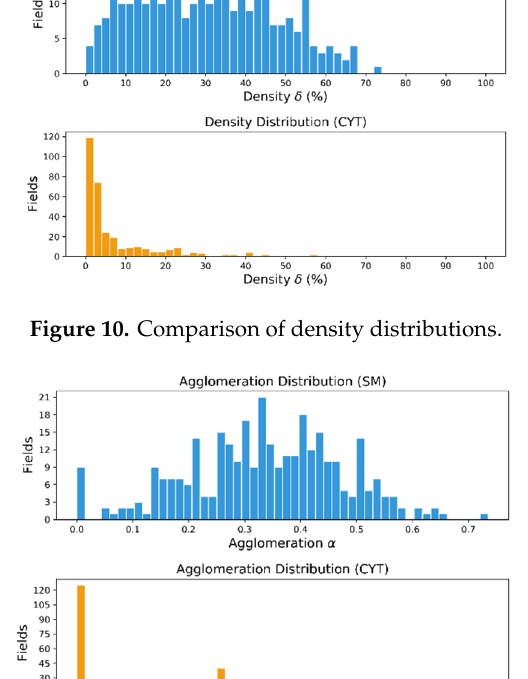
Figure 10. Comparison of density distributions. Figure 11. Comparison of agglomeration